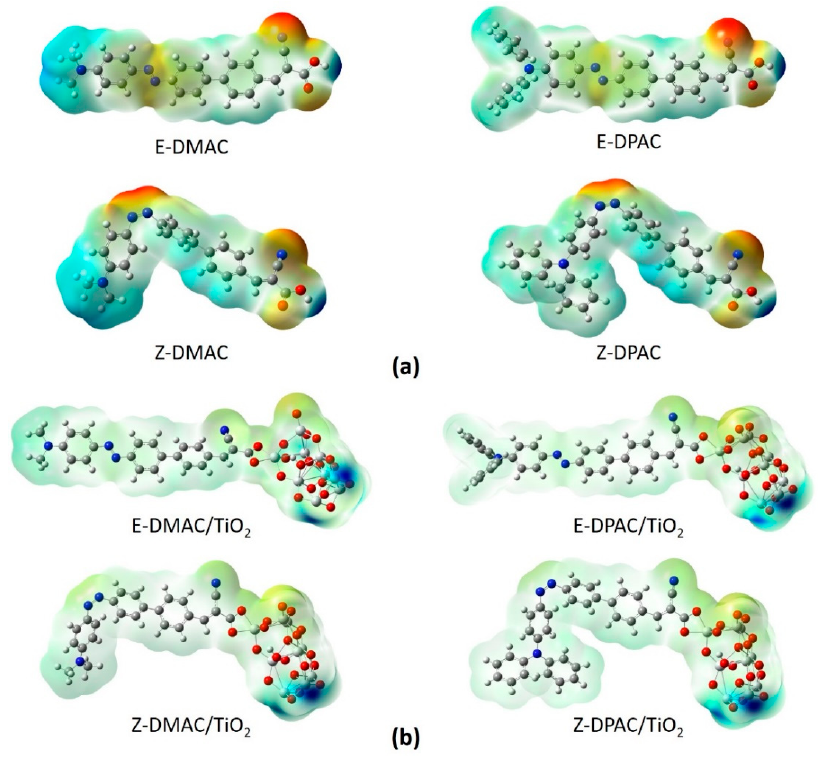
Figure 6. Molecular electrostatic potentials of cis and trans isomers of DMAC and DPAC as ( a ) isolated dyes and ( b ) dye/TiO 2 complexes.